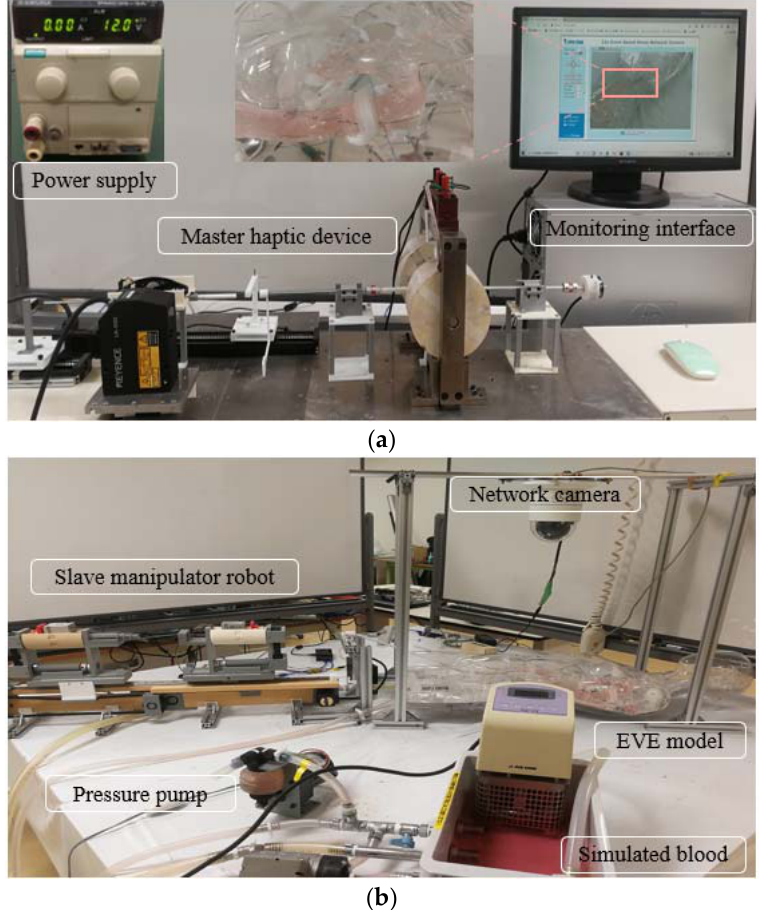
Figure 15. Experimental setup for in vitro experiments: ( a ) the view of master operation side; ( b ) the view of slave manipulator side.